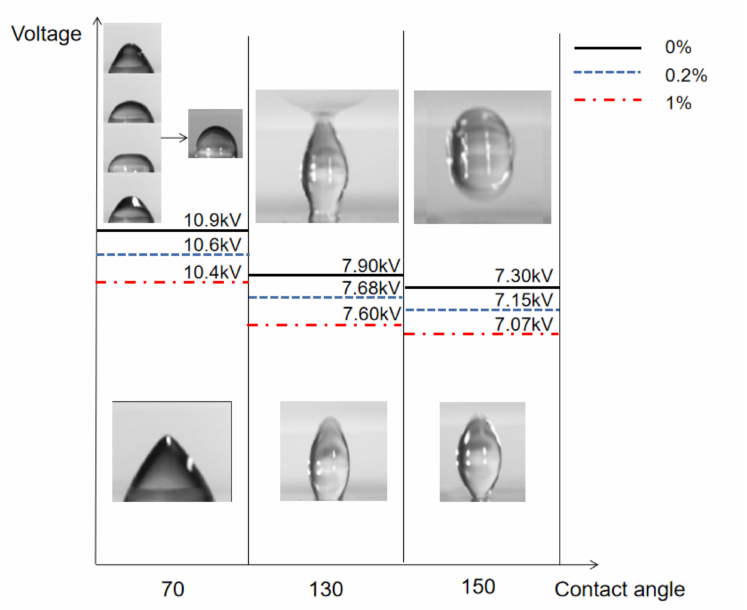
Figure 5. Critical voltage to overcome monotonic equilibration to a static droplet on hydrophilic, hydrophobic, and superhydrophobic substrate for three different PEO concentrations.